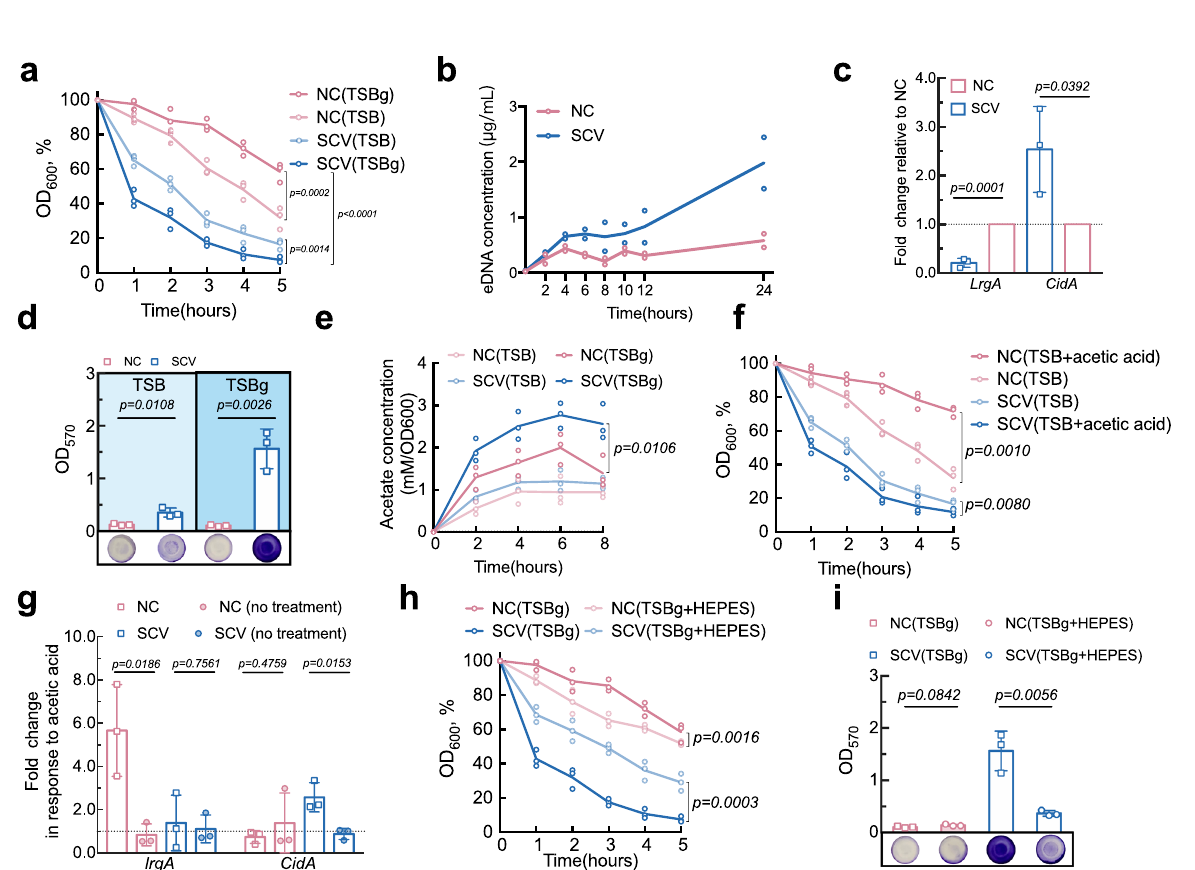
Fig. 5 Increased release of extracellular DNA (eDNA) facilitates bio fi lm formation of S. epidermidis stable SCV. a Representative confocal laser scanning microscopy images of bio fi lms formed by S. epidermidis stable SCV and normal counterpart (NC). Bio fi lm were grown in TSBg for 24 h and then stained with propidium iodide (PI, for dead cells), SYTO9 (for live cells), and WGA-Alexa Fluor TM 350 (for PIA). b Analysis of the confocal laser scanning microscopy z-stack images using COMSTAT2 (http://comstat.dk) and ImageJ software (https://imagej.nih.gov/ij). Data shown are mean ± SD from three technical replicates. c Semiquantitative measurement of eDNA released by S. epidermidis stable SCV and NC into bio fi lm. M: 1 kb marker. d Mean fl uorescence intensity of PIA within bio fi lm and semiquanti fi cation of PIA retrieved from bio fi lm formed by S. epidermidis stable SCV and NC. The numbers shown are dilution factors of PIA extracts. Data shown are mean ± SD from three technical replicates. e Effects of DNase I and protease K on bio fi lm biomass. Data shown are relative optical density at 570 nm of bio fi lm biomass after treatment as indicated with DNase I or protease K or none of both. Data shown are mean ± SD from three biological replicates. Unpaired Student ’ s t test was used for statistical analyses after Shapiro – Wilk normality test.